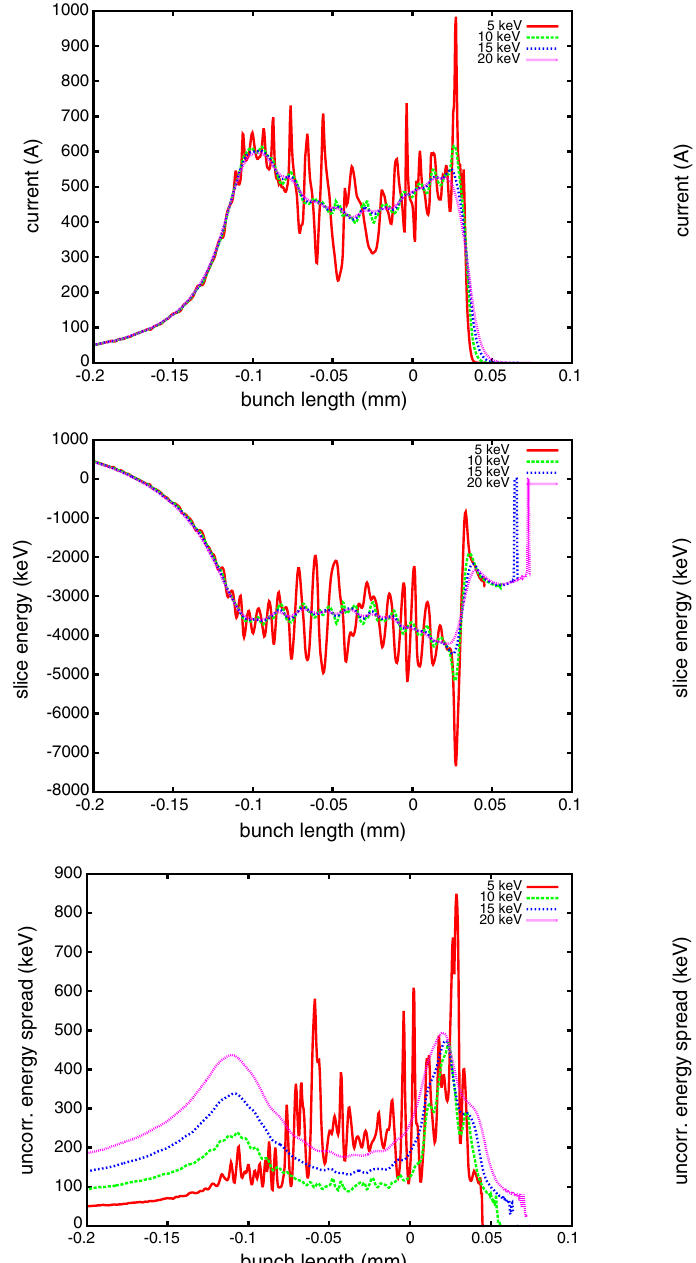
FIG. 9. Final electron beam current profiles with initial 5% temporal laser modulation and different modulation periods through the nominal two bunch compressor